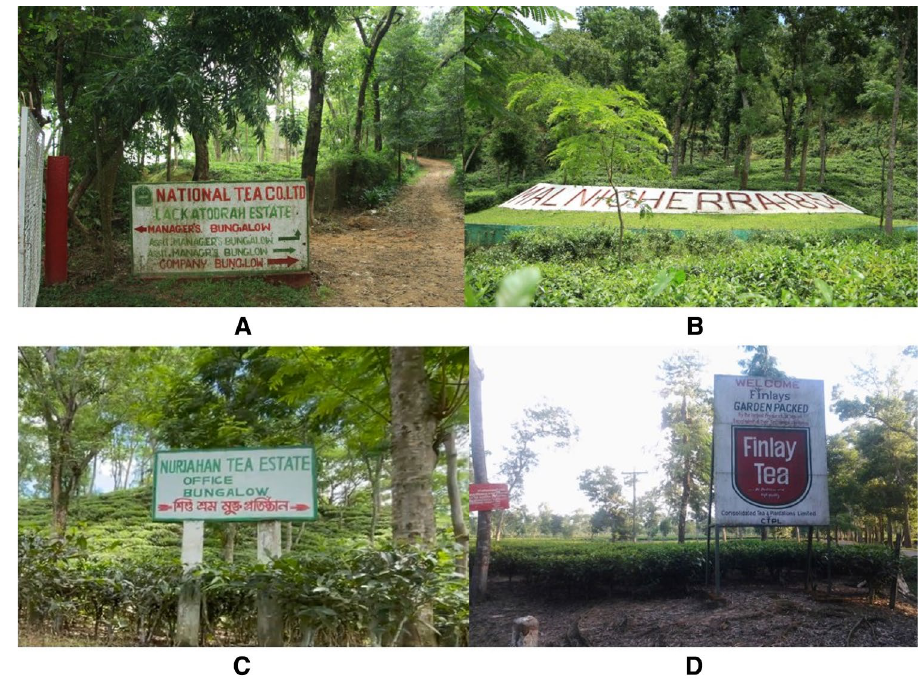
Figure 1. Research data collection places; ( A ) National Tea Company Ltd., ( B ) Malnicherra Tea Garden, ( C ) Nur Jahan Tea Garden, ( D ) Finlay Tea Estate.